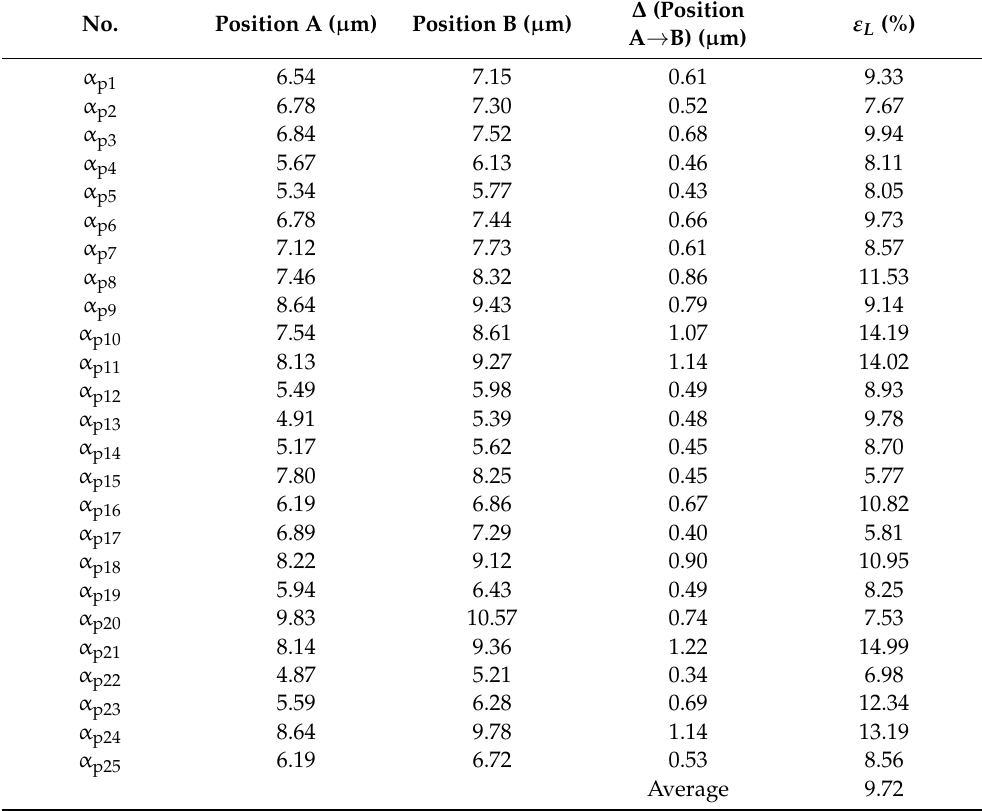
Table 1. Calculation of ε L values for α p phase (Figure 8) from positions A to B.